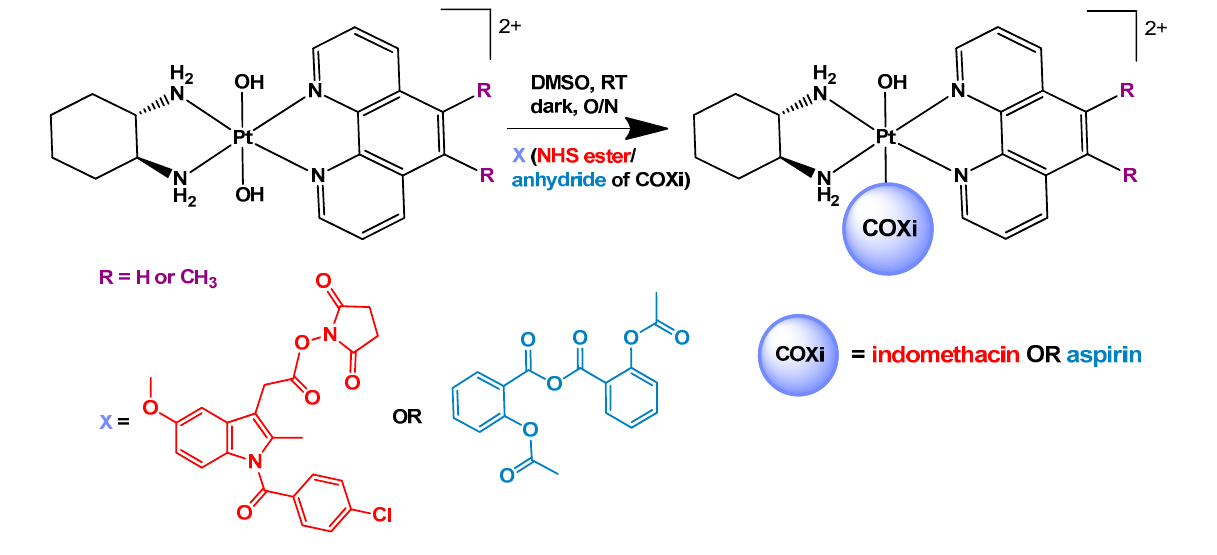
Scheme 1. The synthetic scheme for the synthesis of the platinum(IV) prodrugs comprising of COX inhibitors (COXi) indomethacin ( 1 and 2 ) and aspirin ( 3 and 4 ) in the axial